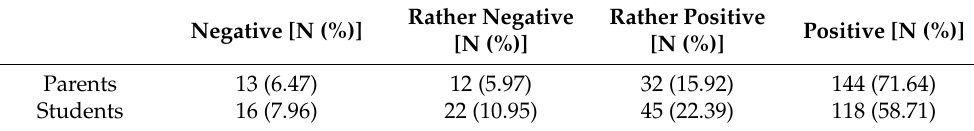
Table 5. Attitudes towards vaccination against COVID-19.